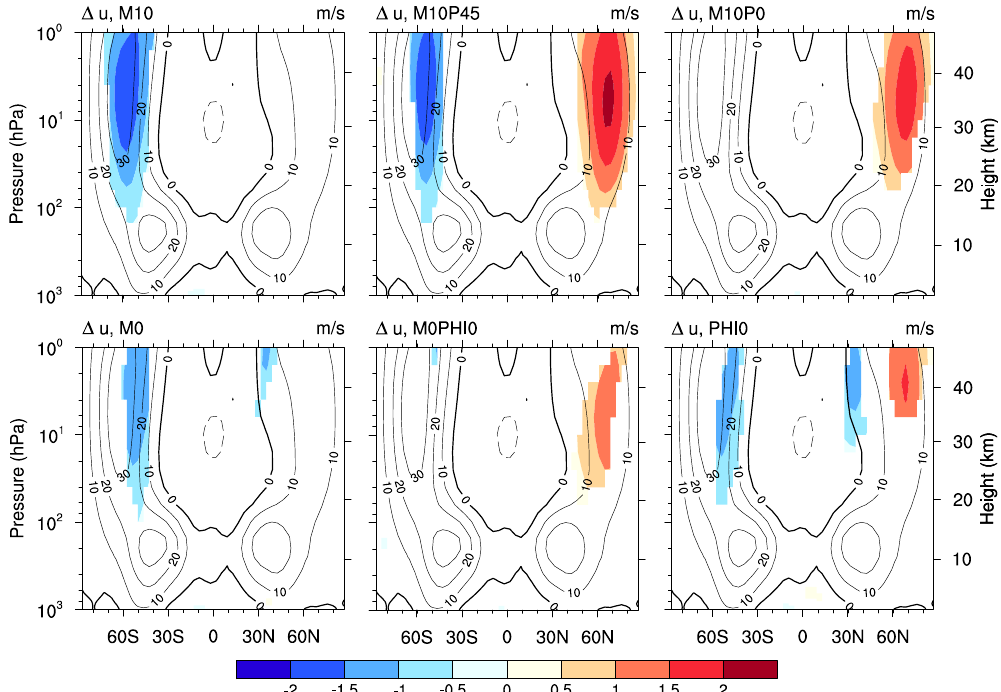
Figure 4. Simulated effects on zonally averaged mean annual zonal wind ( u ). Coloured areas are significant at a 10% level. Contours show the actual wind velocity of the reference run in 10ms − 1